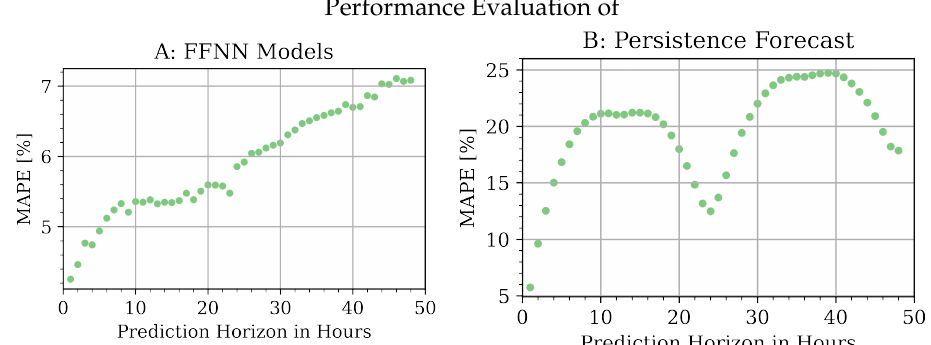
Figure 9. Performance evaluation of ( A ) the 48 FFNN model based on their in-sample MAPE scores on the full data set and ( B ) the persistence forecast with a horizon between one and 48 h. Generally, the FFNN models show increasing forecast errors for larger forecast horizons. For the persistence forecast, the performance increases, when the horizon coincides with the daily